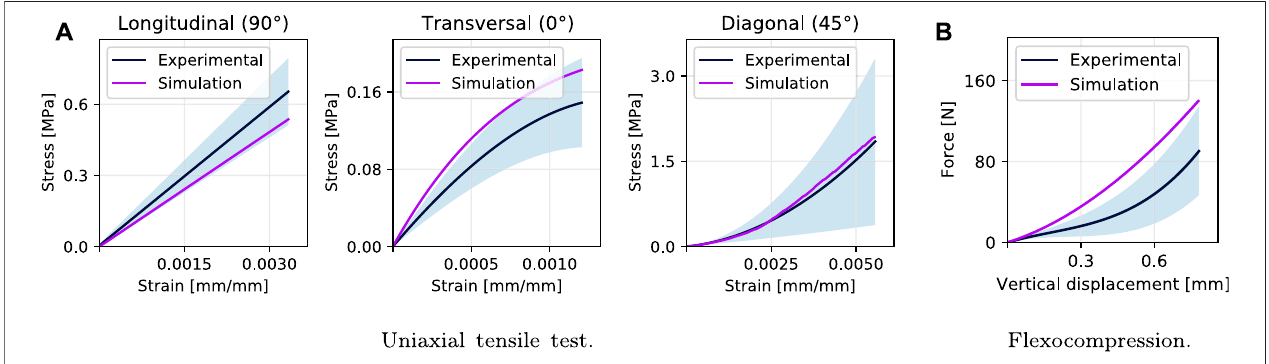
FIGURE 8| Results of simulations and comparison with experimental tests: (A) shows the simulation results of the tensile test, both for the elasticproperties fi tting stage (longitudinal and transversal direction) and for the validation stage (diagonal). (B) shows the validation of the orthotropic model adopted with the adjusted properties obtaining an error of approximately 23%.